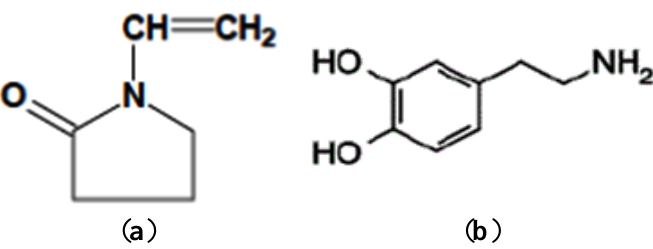
Figure 1. Molecular structures of monomers: ( a ) N-vinyl-2-pyrrolidone; and ( b ) dopamine.